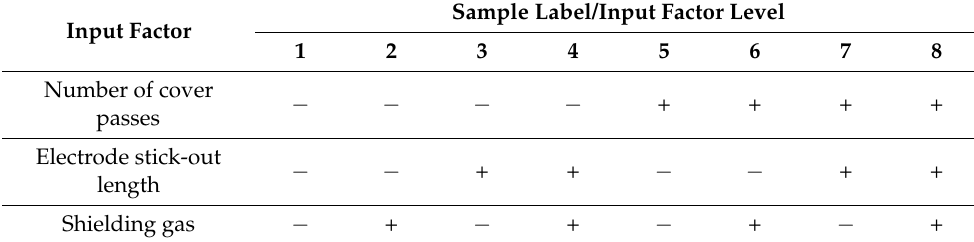
Table 2. Experimental